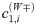
Numerical values of c1,i(W∓) of protons.Open circles denote the data obtained directly from the fitting of LSq to the fluxes at 1 MeV/n, while the solid lines represent the corresponding data calculated using Eq (5).